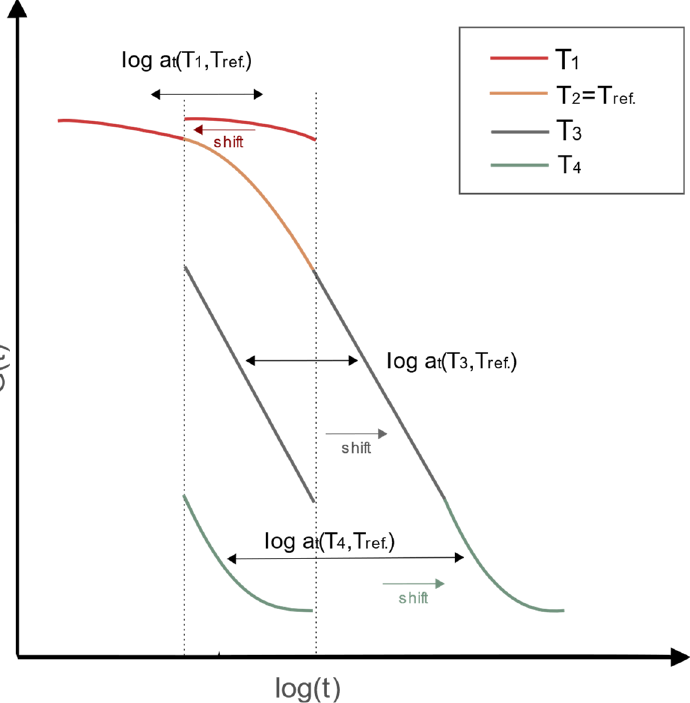
Figure 4. Horizontal shift of temperature curves to match reference temperature curve, T 1 < T 2 < T 3 < T 4.